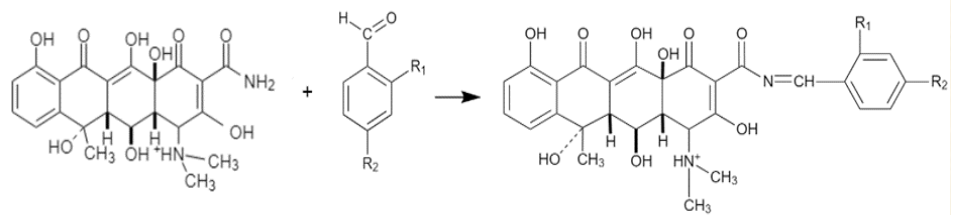
Figure 2. Synthesis of oxytetracycline derivatives. OXI-A (R 1 = – NO 2 ; R 2 = – H); OXI-B (R 1 = – H; R 2 = – H); OXI-C (R 1 = – H; R 2 = – Br); OXI-D (R 1 = – H; R 2 = – OH).